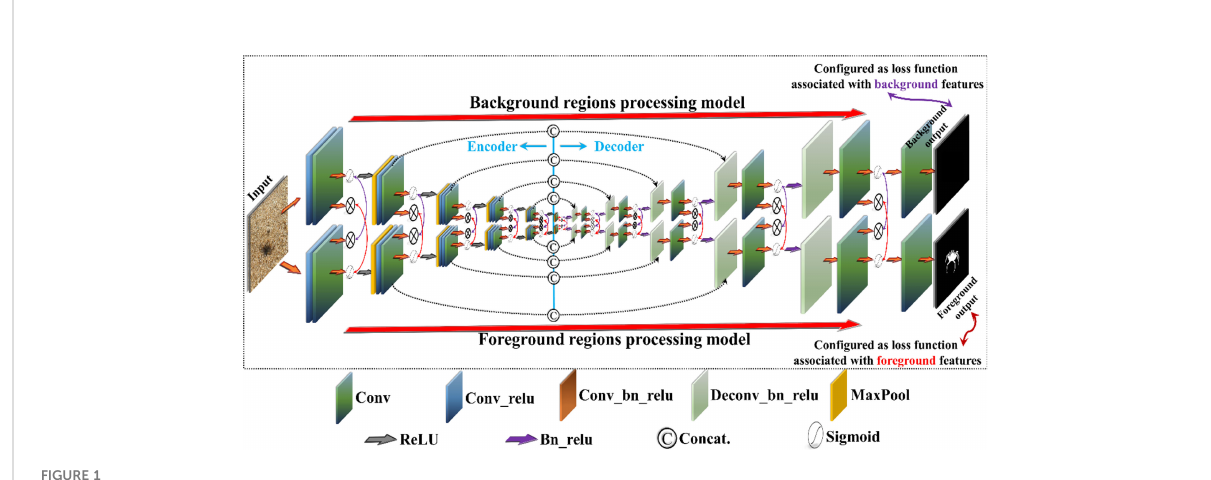
FIGURE 1 Structure of proposed